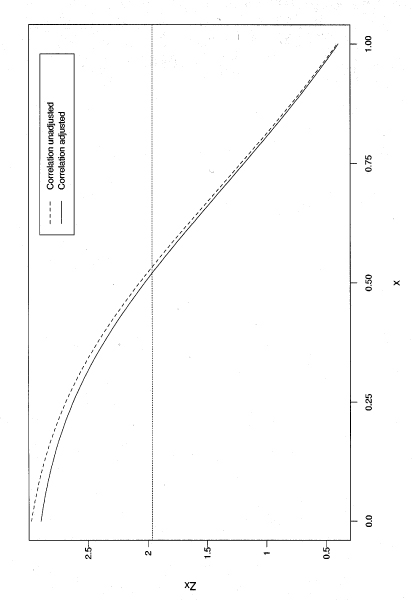
Plot of the trend tests Zx versus scores x.